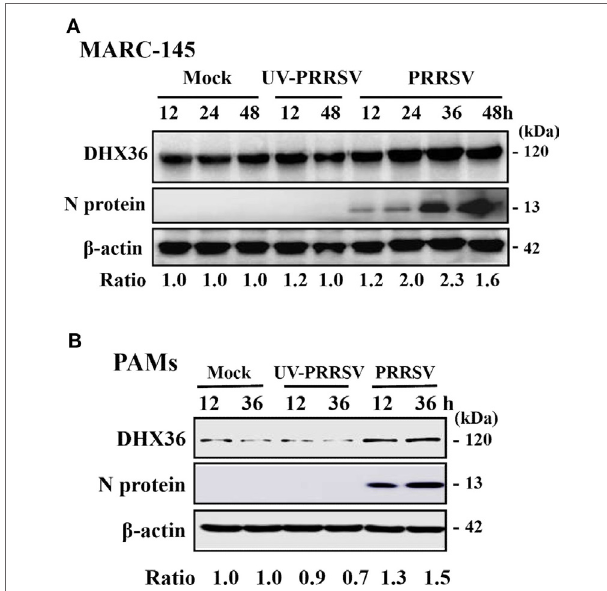
FigUre 1 | DExD/H-box helicase 36 (DHX36) expression is modulated by porcine reproductive and respiratory syndrome virus (PRRSV) but not UV-inactivated PRRSV in MARC-145 cells and pulmonary macrophages (PAMs). MARC-145 cells (a) and PAMs (B) were mock-infected, infected with PRRSV, or UV-inactivated PRRSV at an MOI of 1. Cell lysates were collected at the indicated time points and the expression of endogenous DHX36 protein was analyzed by Western blot with DHX36-specific antibody. Relative levels of DHX36 in comparison with mock-infected cells are indicated as fold change below the images. Western blot with a specific monoclonal antibody against PRRSV N protein demonstrates PRRSV infection. All blots were also incubated with anti-actin antibody to verify equal protein